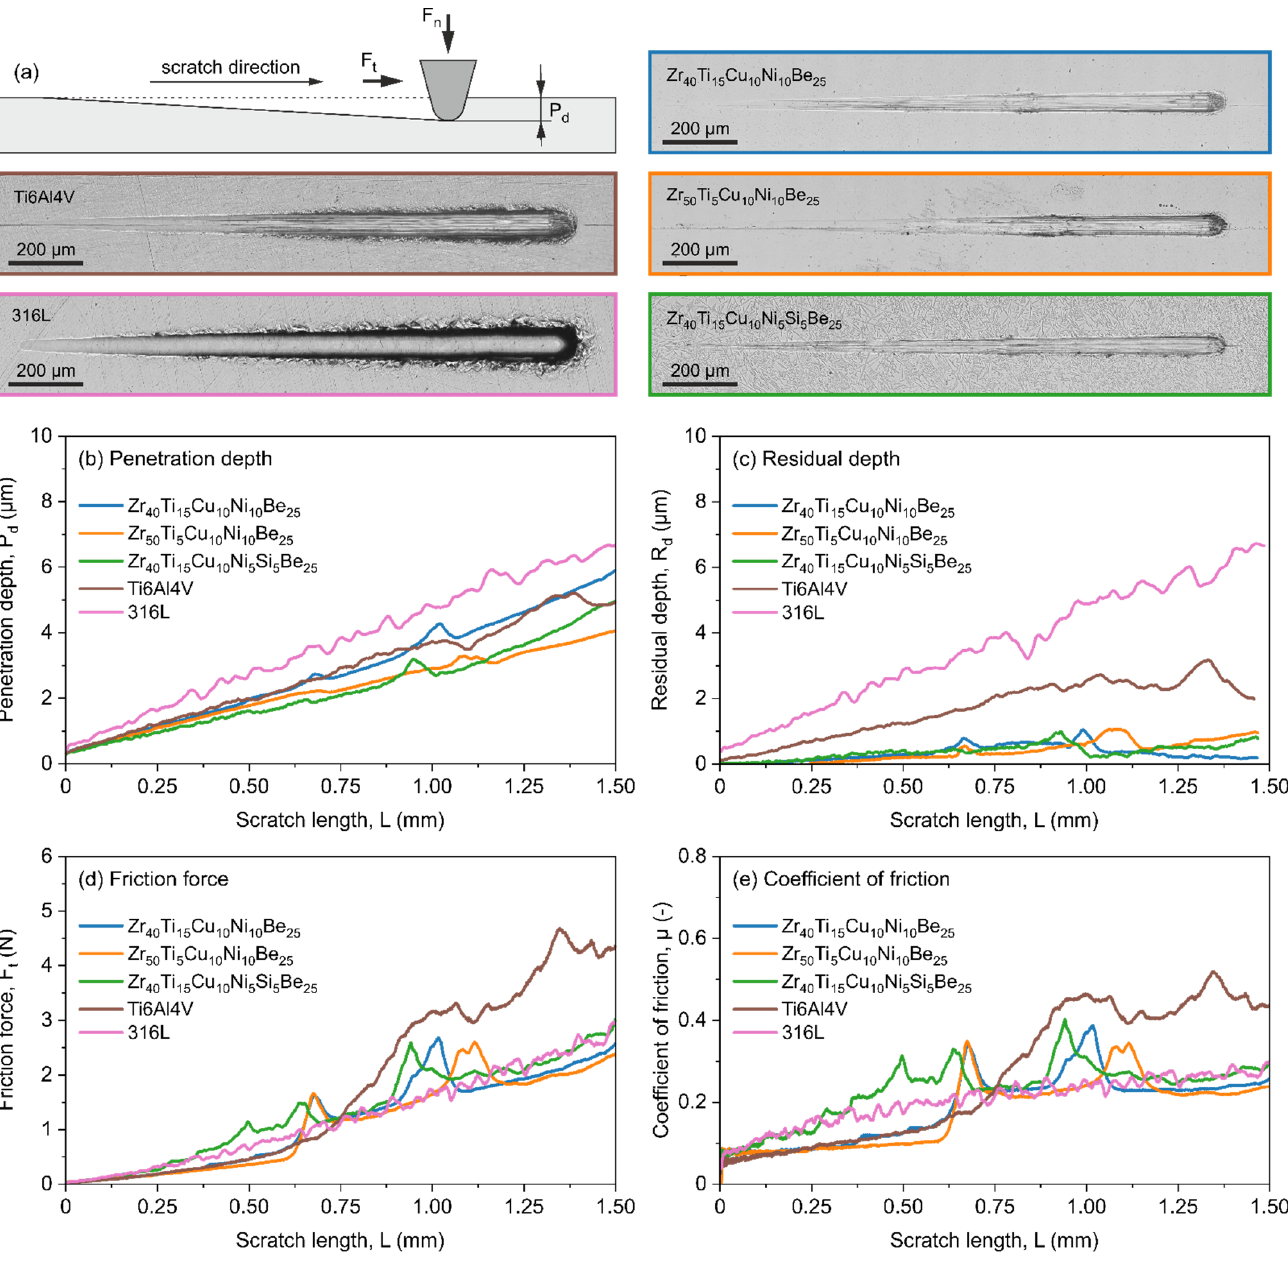
Figure 3. Photos of scratches ( a ) and mechanical parameters such as penetration depth ( b ), residual depth ( c ), friction force ( d ), and coefficient of friction ( e ) for the Zr 40 Ti 15 Cu 10 Ni 10 Be 25 , Zr 50 Ti 5 Cu 10 Ni 10 Be 25 , Zr 40 Ti 15 Cu 10 Ni 5 Si 5 Be 25 , and reference 316L surgical steel and Ti6Al4V alloy ob- tained in scratch tests.